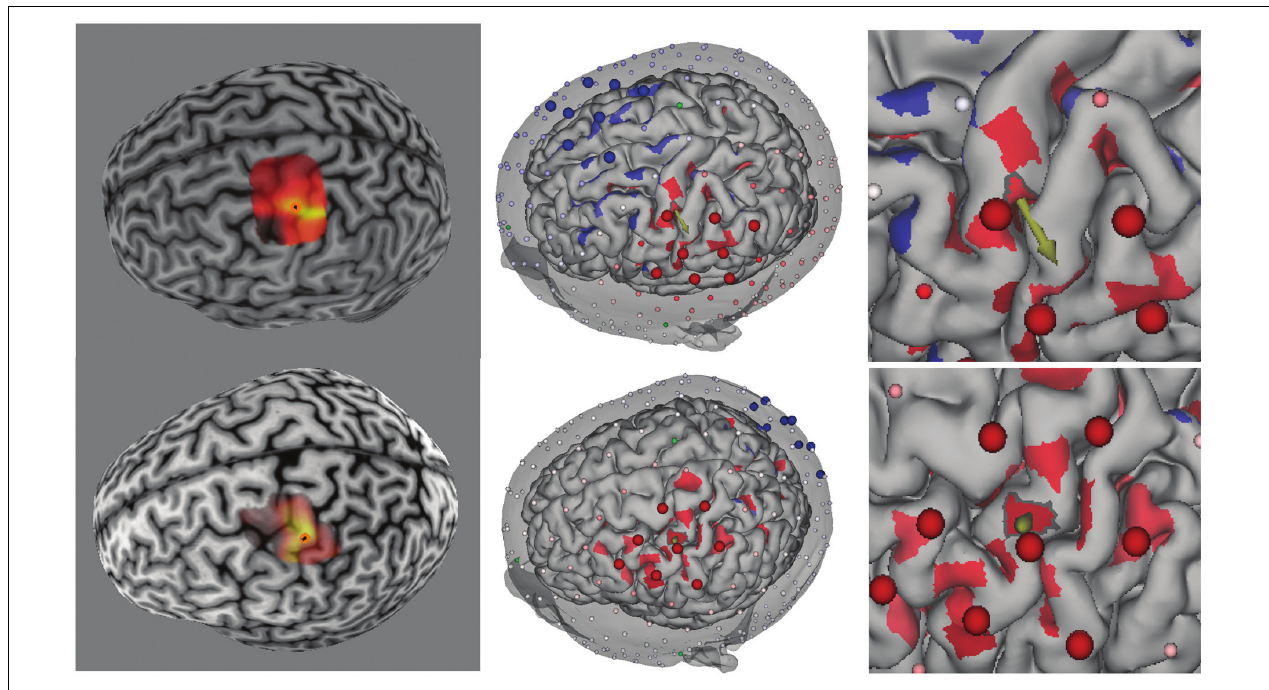
FIGURE 2 | (Left) TMS-induced MEP heat map over M1 for two participants (top and bottom rows). Brighter colors represent larger MEP amplitudes. Orange circle denotes “hotspot.” (Middle) Reciprocity-based optimized selection of current injection electrodes for hotspot targets. Shown are eight anode (large red electrodes) and eight cathode (large blue electrodes). Note that the electrode montage is substantially different between the two participants because of the cortical geometry of the target (cortical patch with outline and arrow pointing in the average direction for the given cortical patch). Color intensity on the cortex represents current density normal to the cortical surface (red = anodal current direction, blue = cathodal current direction). Note that the current density was thresholded to remove the lowest 50% values in order to highlight the locations of high current density. (Right) Zoomed in view of the hotspot location to show the normal orientation (arrow) of the target